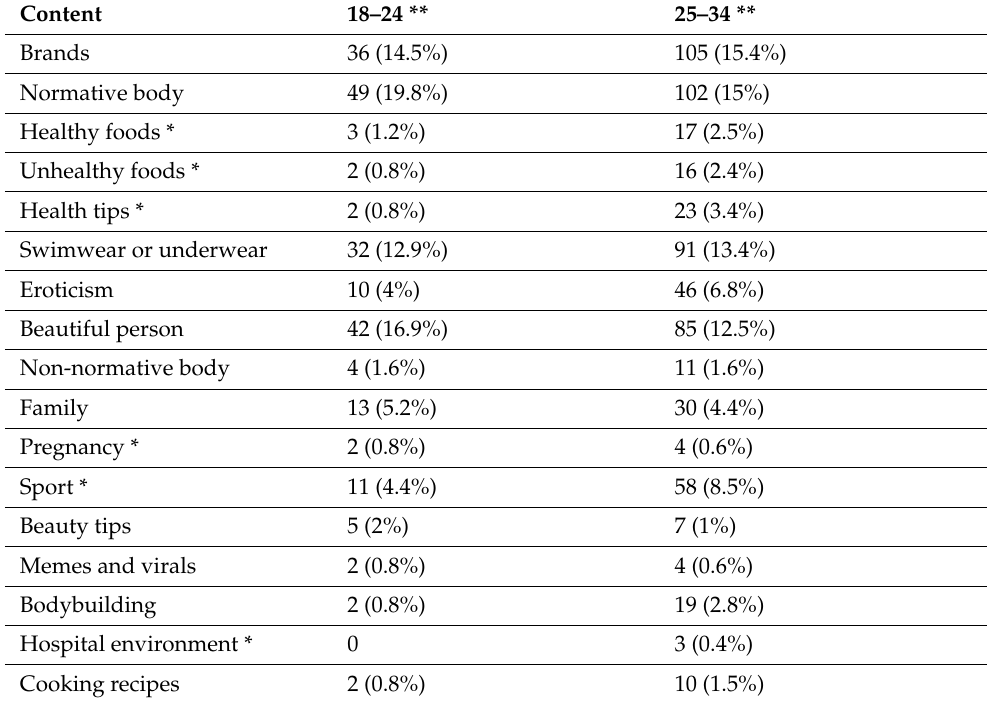
Table 5. Type of content published according to the predominant age range of the influencer’s followers. Source: own